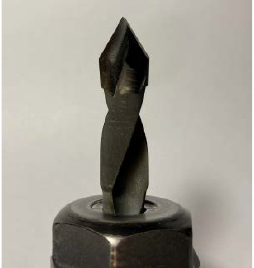
Figure 2. The standard two-blade drill bit intended for drilling in wood-based panels (catalogue symbol—K0500013, WP-01, FABA S.A. Poland), which was used during the experimental tests.